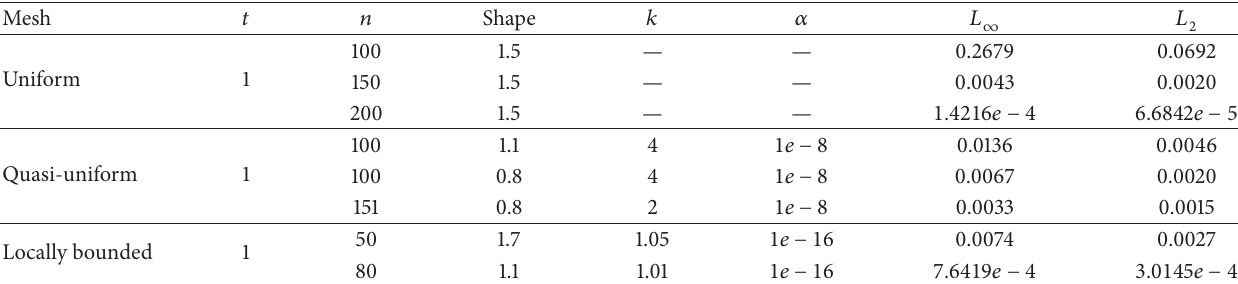
Figure 3: The plot of exact and approximate solutions of Example 5 with 100 uniform, quasi-uniform, and locally bounded nodes (resp., (a)–(c)). Table 2: The results of Example 6 with different number of nodes and different mesh